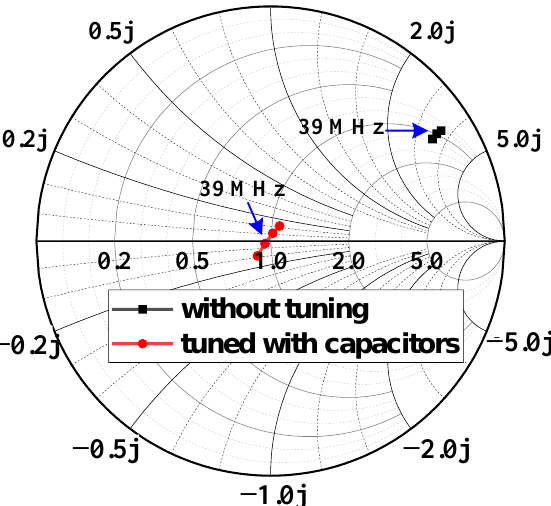
Figure 3. The simulated Smith Chart of the designed turnstile antenna.